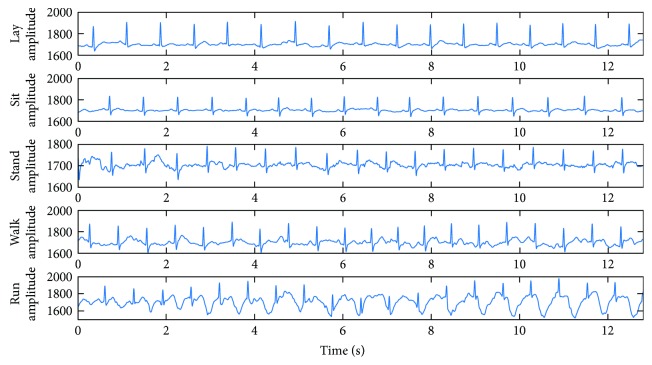
The ECG signals for compression tests.